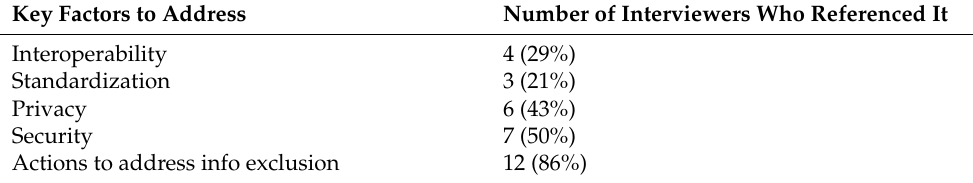
Table 6. Important factors in